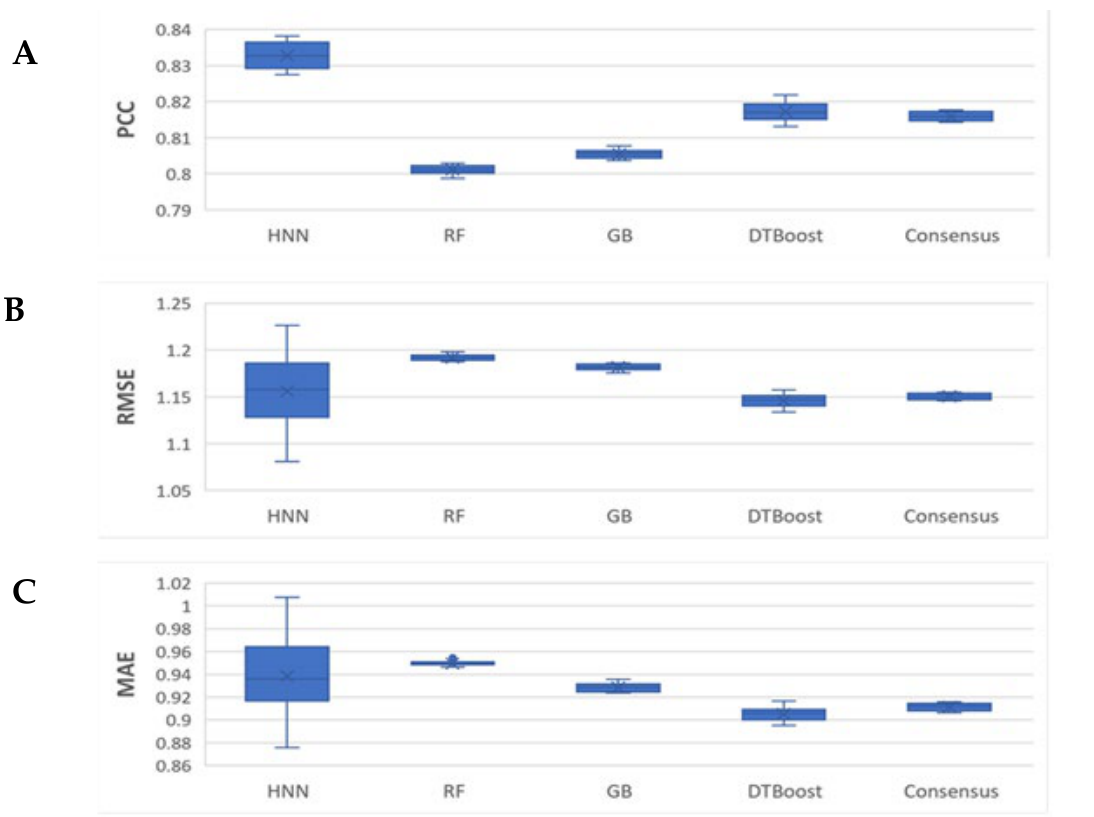
Figure 5. The HNN-denovo performance comparison to other models for the K i binding data. ( A ) PCC, ( B ) RMSE, and ( C ) MAE of the binding affinity prediction by HNN, RF, GB, DT, and consensus methods.